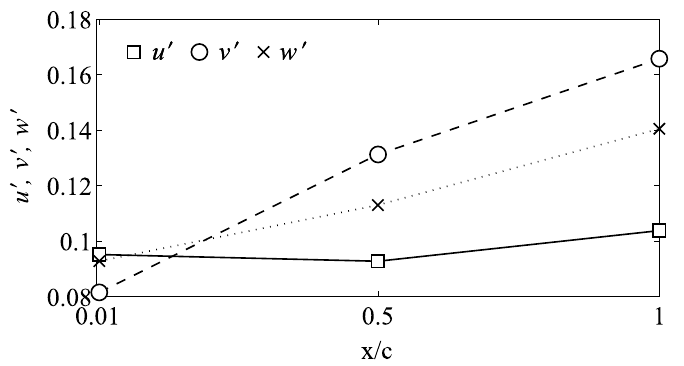
Fig. 5 Variation of velocity fluctuations: u (cid:5) , v (cid:5) and w (cid:5)